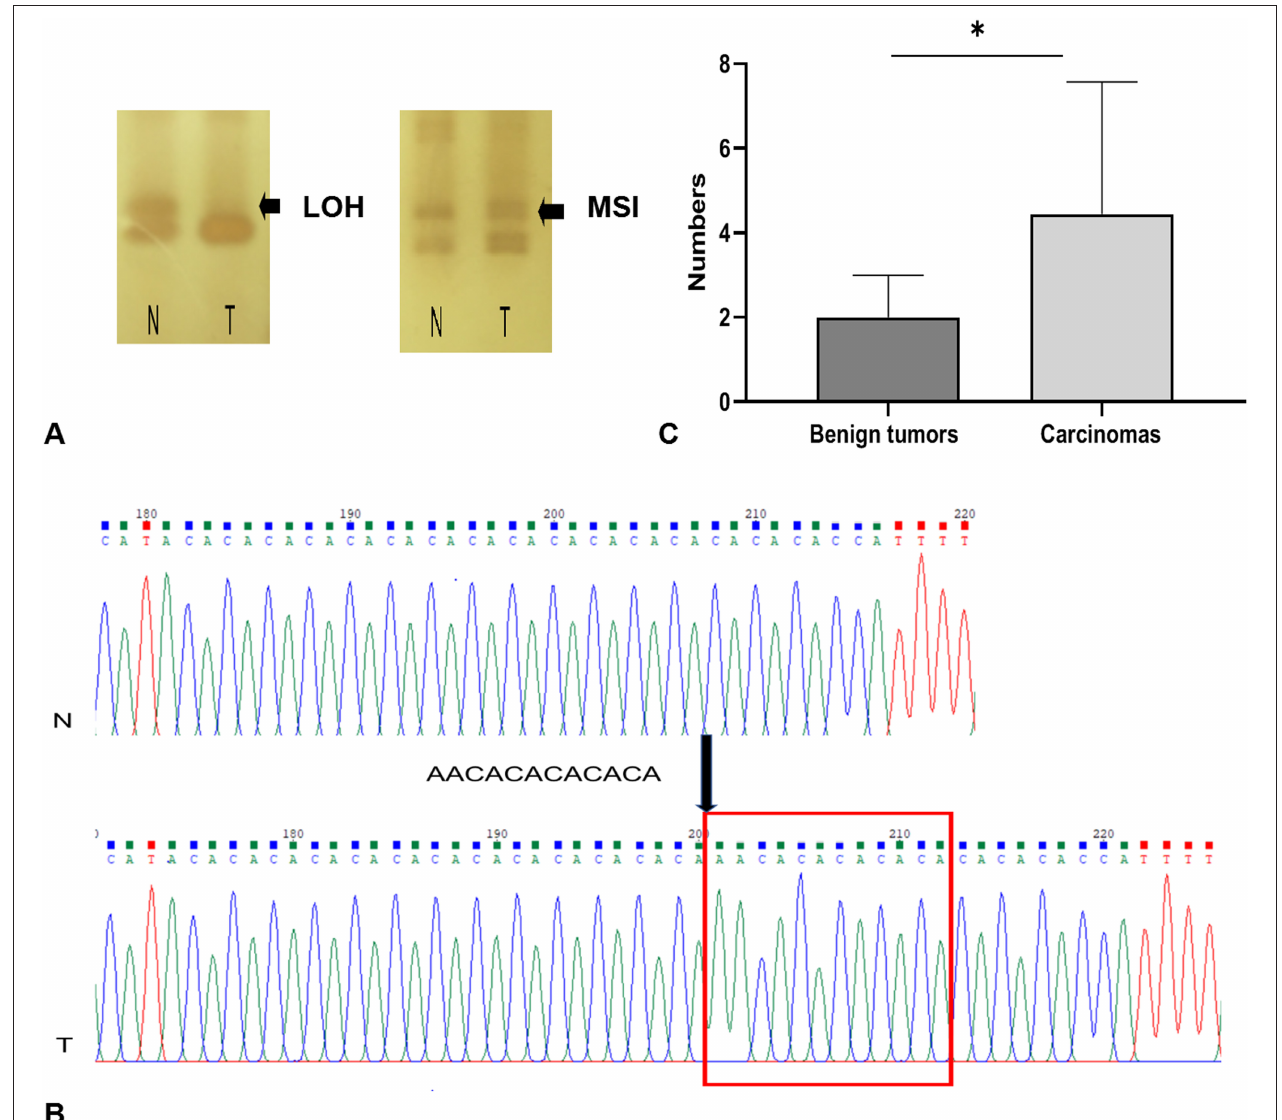
FIGURE 2 | MSI and LOH occurring in CMTs. (A) MSI and LOH detection in denatured polyacrylamide gels. (B) The sequencing result of MSI locus, there was a repetitive fragment insertion in tumors. (C) Carcinomas have more mutation loci than benign tumors. *indicates a significant difference between the two groups, P <